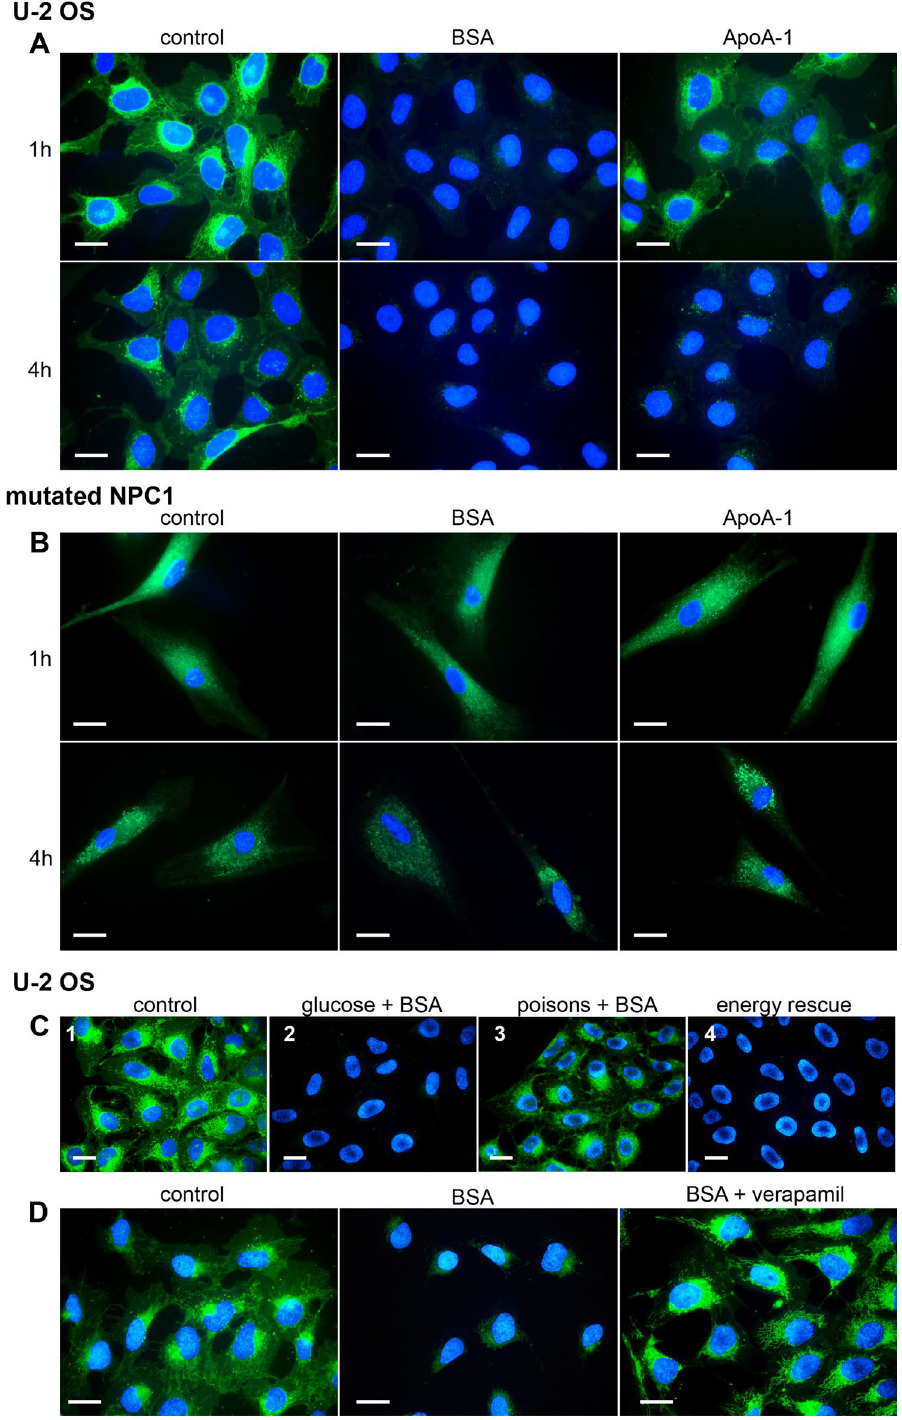
Figure 5. Efflux of Sterolight probe is dependent on energy and functional transporters. U-2 OS cells ( A ) or NPC1 mutated cells ( B ) were pulsed with Sterolight probe (1 µg/ml) and transferred to serum-free medium containing efflux acceptors: 0.2% BSA or 10 µg/mL ApoA-I. The fluorescence intensity of cells was recorded under identical settings after 1 and 4 h incubation. ( C ) Cells pulsed with Sterolight probe were chased for 1 h: 1) in the absence of energy poisons and BSA (negative control), 2) in the presence of BSA (positive control), 3) in the presence of BSA and energy poisons, 4) cells treated with BSA and energy poisons were washed and switched to the medium containing BSA and glucose for additional 1 h incubation to retrieve energy. ( D ) Inhibition of Sterolight efflux by verapamil. U-2 OS cells pre-incubated with 10 µM verapamil for 1 h were pulsed with Sterolight probe, washed and chased in the presence of 0.2% BSA (acceptor) with verapamil for 1 h (right panel). Control cells were labelled with Sterolight probe without BSA or verapamil (left panel). As positive control for efflux were used cells exposed to Sterolight pulse with subsequent incubation in medium containing BSA (middle panel). Cell nuclei were stained for the last 5 min of incubation with Hoechst 33342 (blue). The presented results are representatives of three independent experiments. Scale bar 10